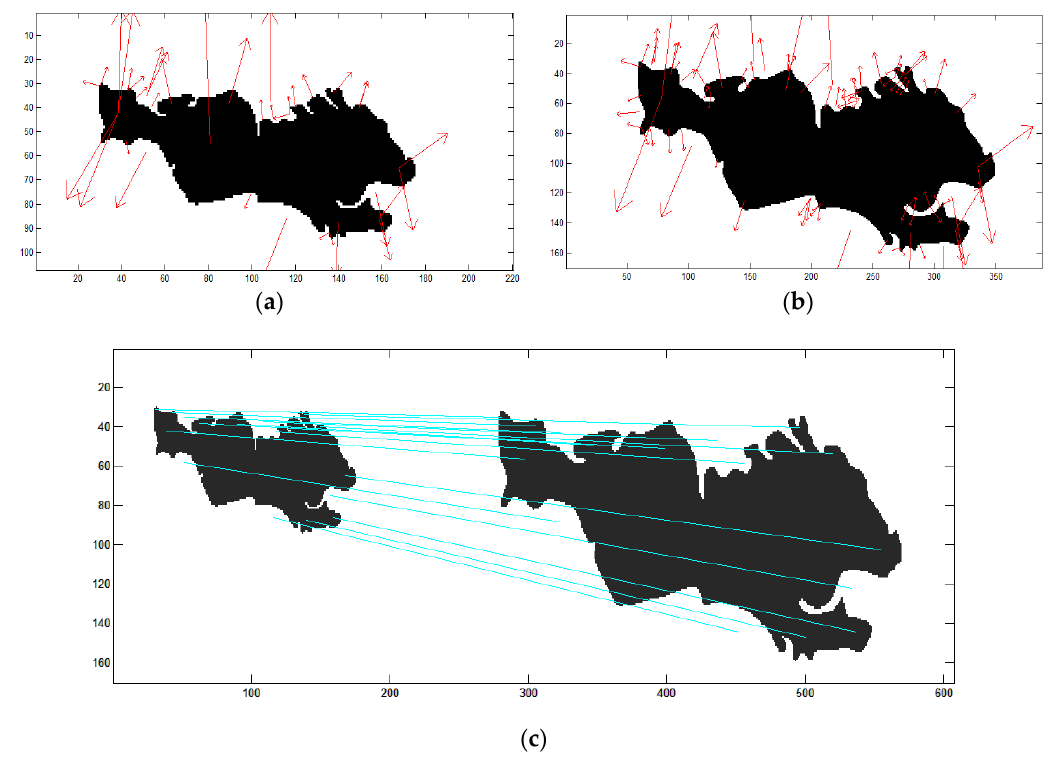
Figure 6. Local feature calculation using the scale-invariant feature transform (SIFT) algorithm. ( a ) A lake from a low level; ( b ) The same lake from a high level; ( c ) Matching results.